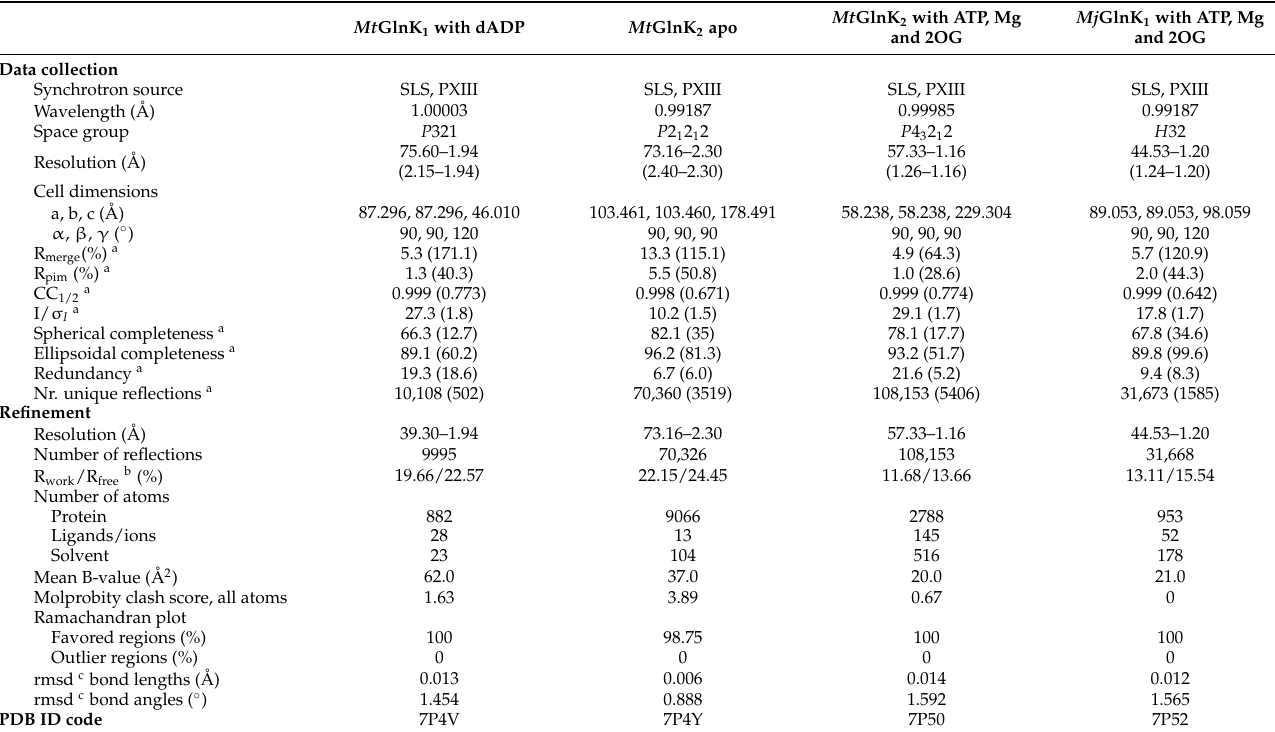
Table 3. X-ray crystallographic data and refinement